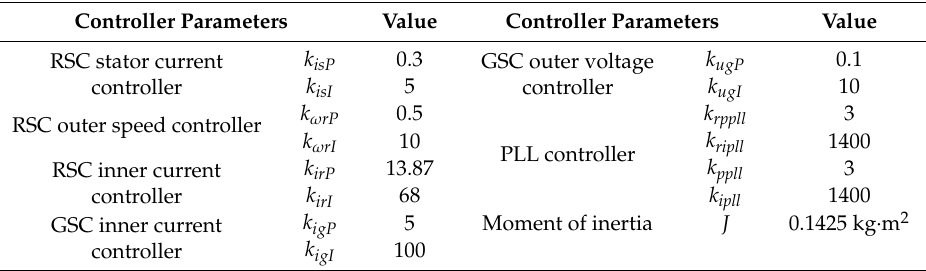
Table 2. The controller parameters of RSC and GSC.